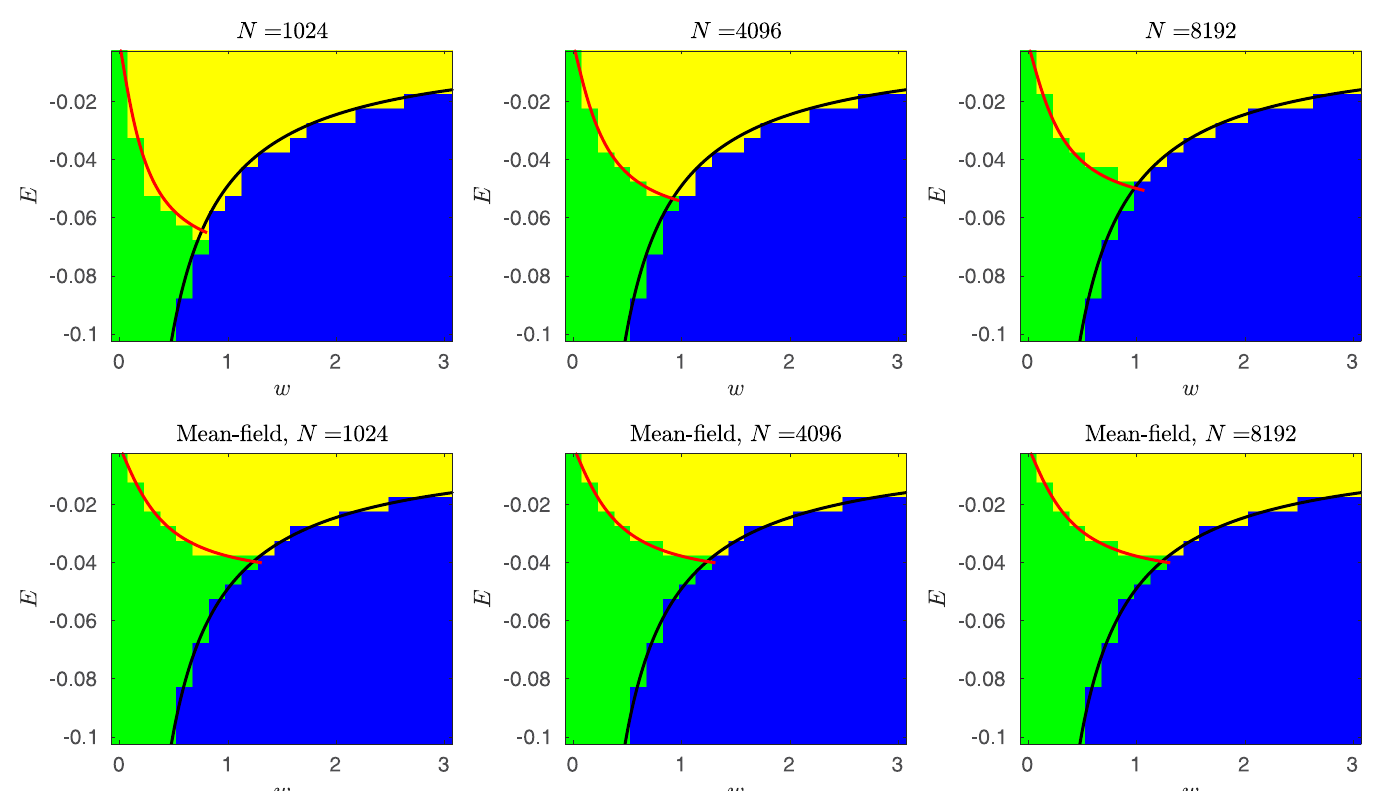
Fig 6. Phase diagrams derived from mean-field approximations. Top row: phase diagrams were obtained from exact continuous time simulations (temporal Gillespie algorithm) of the proposed probabilistic model on ER networks of different sizes N = 1024, 4096, 8192. Red curves indicate the boundary between no-spread and spread phases estimated via mean-field finite-size corrected approximations. Black curves denote the boundary separating the no-seizure phase from the other two phases derived from the mean-field approximations. Bottom row: phase diagrams obtained by the simulation of the mean-field dynamics approximation in discrete-time (Eqs 26, 27 and 28; see also Materials and methods). Red and black curves are the transition boundaries derived from the mean-field approximation without the finite-size correction. As the network size grows, the agreement between the two (top and bottom) phase diagrams improves as expected.